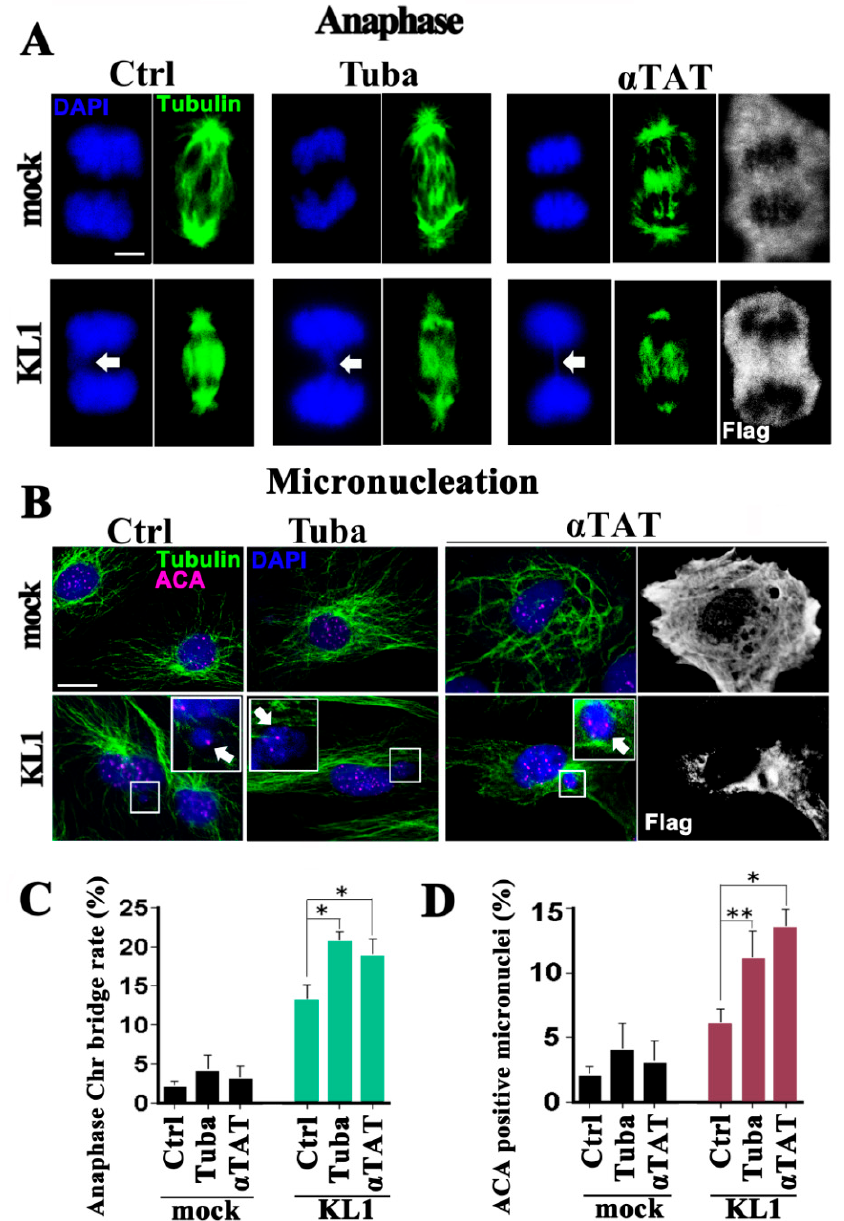
Figure 2. KL1-expressing RFL-6 fibroblasts show elevated chromosome bridging and micronucleation in response to enhanced microtubule acetylation. Equivalent numbers of vector-transfected mock control cells and stably expressing wild-type KL1 cells were plated, treated with tubacin or transfected with α -TAT1 plasmids, cultured and stained with anti-general tubulin (Tubulin), anti-centromere (ACA), or anti-flag (Flag) antibodies and counterstained with DAPI. ( A ) During anaphase, spontaneous chromosome bridges were frequently detected in the KL1-expressing lines. Under microtubule hyperacetylation KL1-expressers but not controls showed increased chromosome bridging (arrows in the DAPI panels). The chromosome bridging morphologies were unchanged either following treatment with tubacin or α -TAT1 overexpression. Bar, 5 µm. ( B ) Cells were stained for tubulin, centromeres (using ACAs), and DNA. In the control cells, ACA signals were detectable in the nucleus. Tubacin treatment (Tuba) or α -TAT1 overexpression ( α TAT) did not induce any increase in micronucleation in the control cells. KL1-expressers spontaneously generated micronuclei